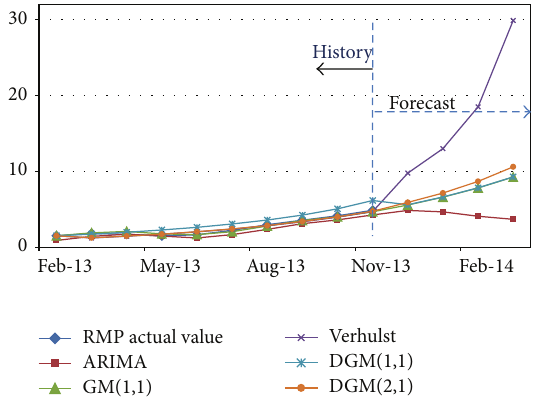
Figure 9: Actual and forecast RMP values for 05